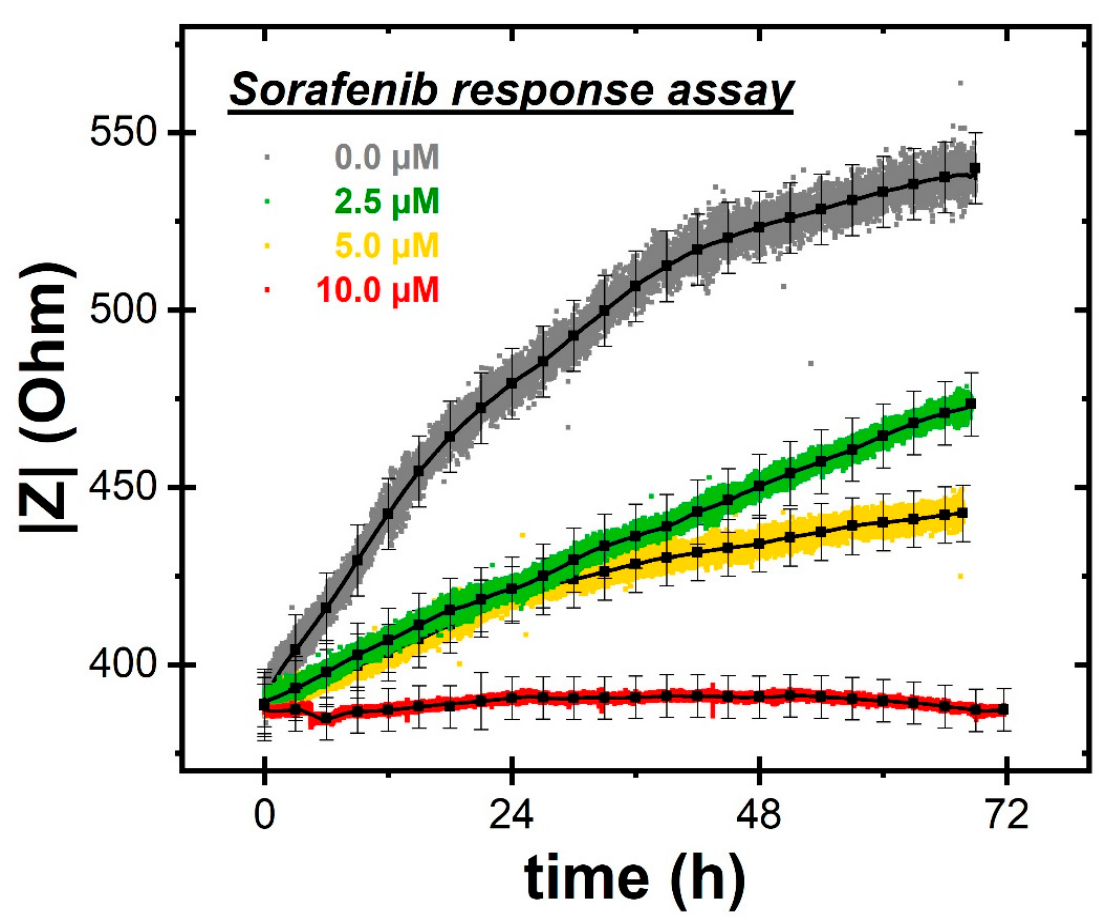
Figure 6. Dose-dependent ECIS cell proliferation assays showing the influence of the Sorafenib concentration on the proliferation rate. Gray curve is in absence of Sorafenib , while green, yellow and red curves are at increasing Sorafenib concentrations from 2.5 µ M, to 5.0 µ M and 10.0 µ M respectively. Black curves show mean ± standard deviation from statistical analyses. Table 1. Comparison among traditional and on chip assays in terms of estimated reagents consumption, operator time, and assay costs.